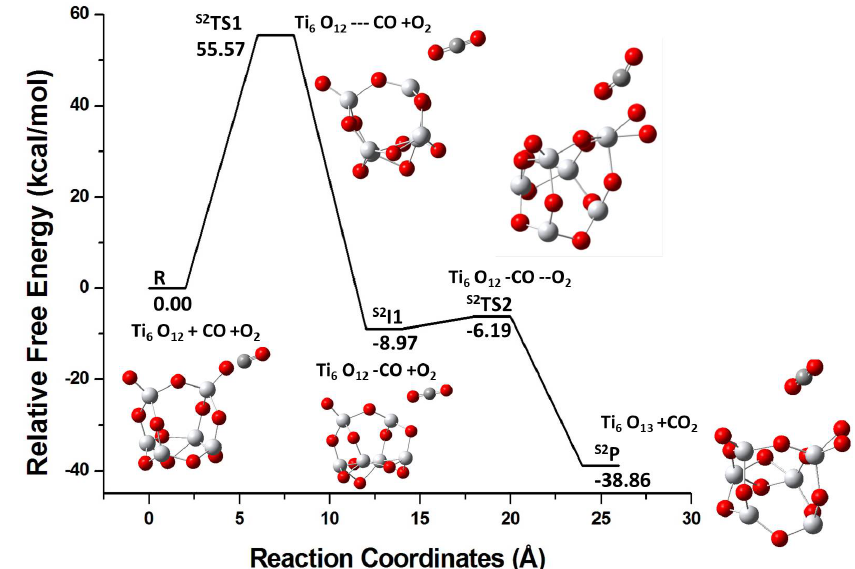
Figure 4. The energy profile for the reaction of the S2 isomer through pathway I R, S 2 TS1, S 2 I1, S 2 TS2, and S 2 P represent reactants (R), transition state 1 (TS1), intermediate state 1 (I1), transition state 2 (TS2), and product (P), respectively.